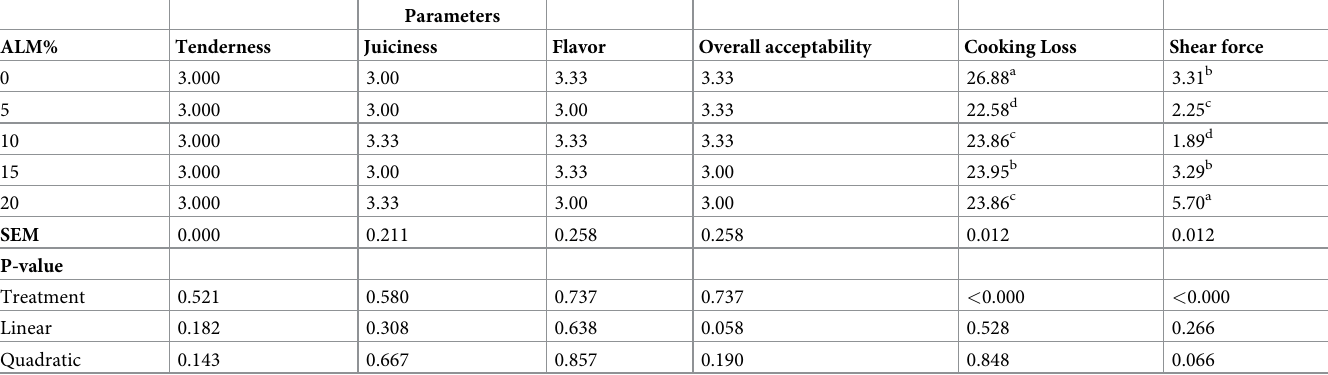
Table 8. Effect of amaranth leaf meal inclusion on sensory attributes, cooking loss, and shear force of Ross 308 broiler chickens.